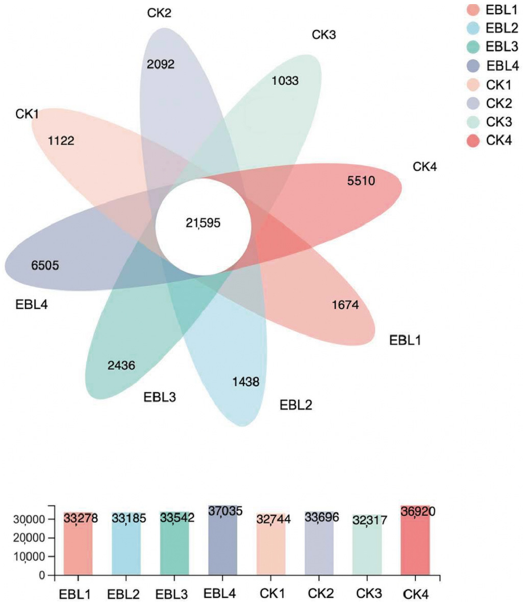
Figure 8. Number and distribution of co-expression and specific expression genes.